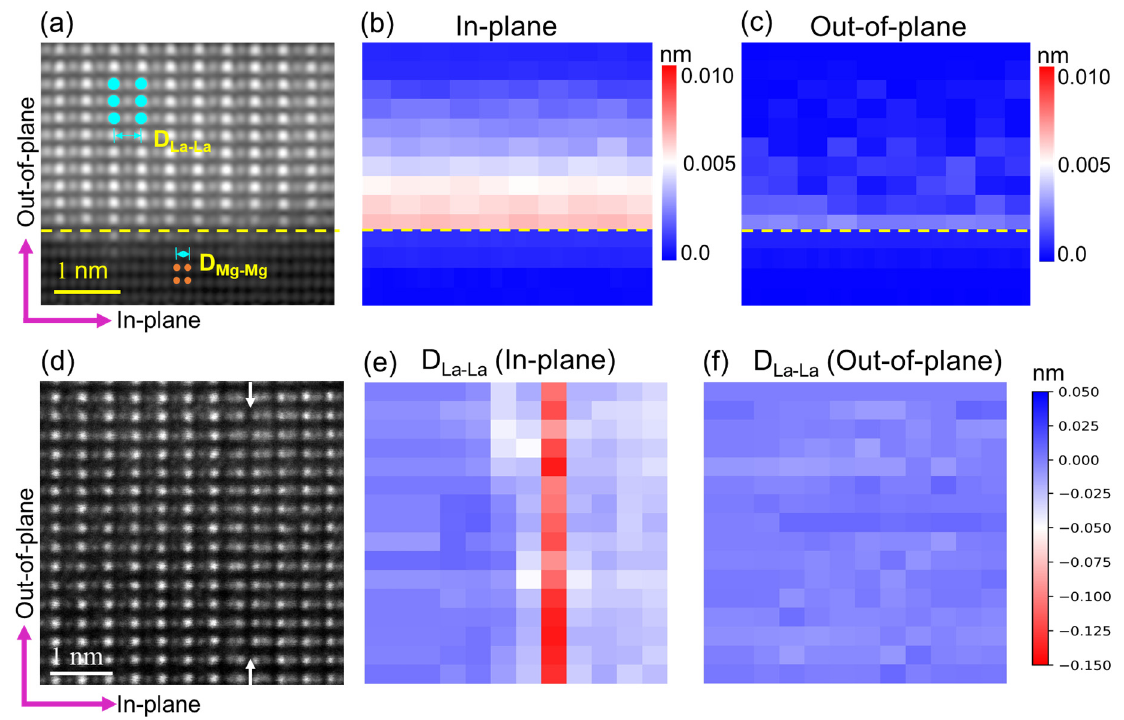
Figure 3. ( a ) HAADF image and ( b , c ) atomic bond length maps of D La-La and D Mg-Mg along the in-plane, and out-of-plane directions, respectively, ( d ) HAADF image of grown LSMO film with an indicated antiphase boundary, ( e , f ) atomic bond length maps of D La-La along in-plane and out-of-plane directions, respectively.